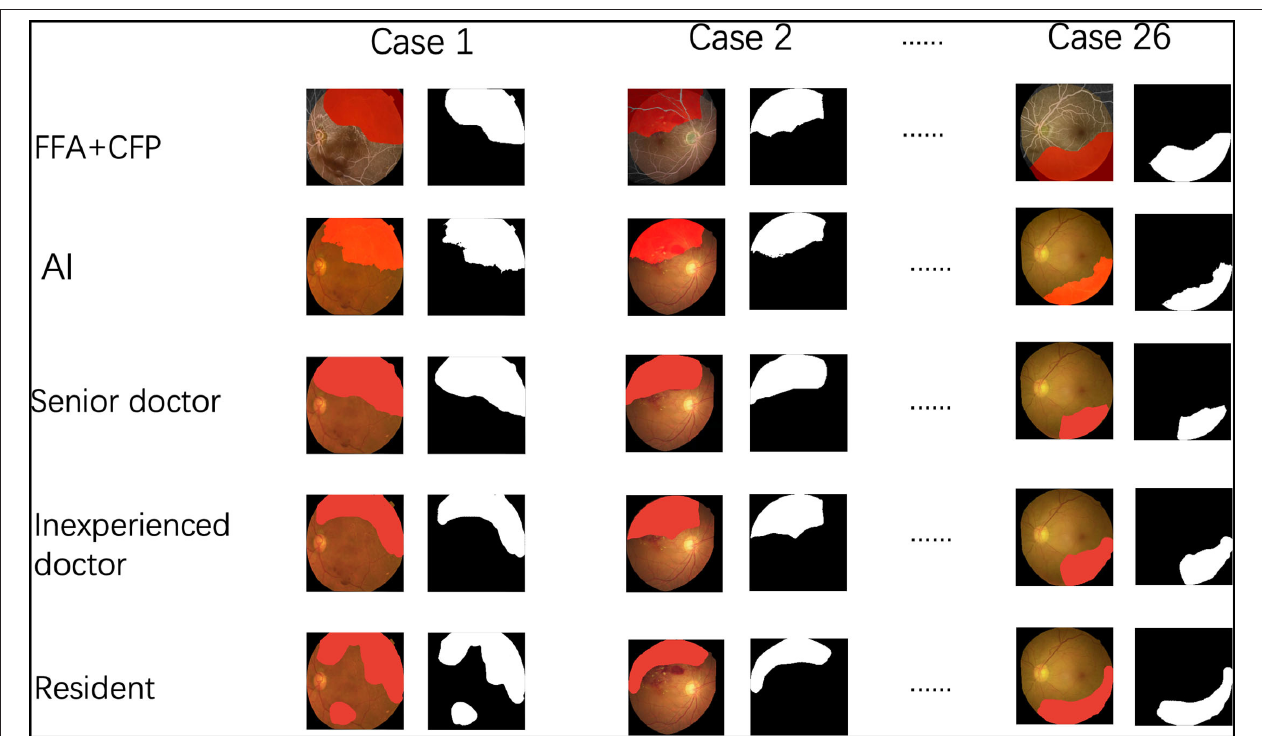
FIGURE 4 | The procedure of the comparison among the artificial intelligence (AI) and three groups of